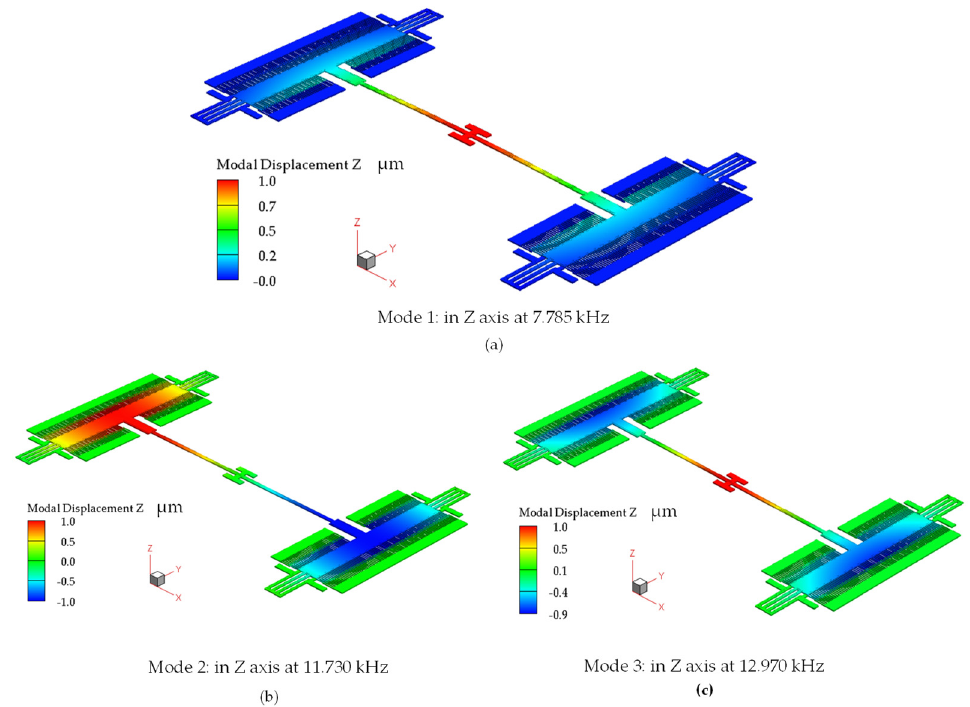
Figure 6. Simulated resonance frequencies showing ( a ) mode 1, ( b ) mode 2 (note: platform becomes a node), and ( c ) mode 3.